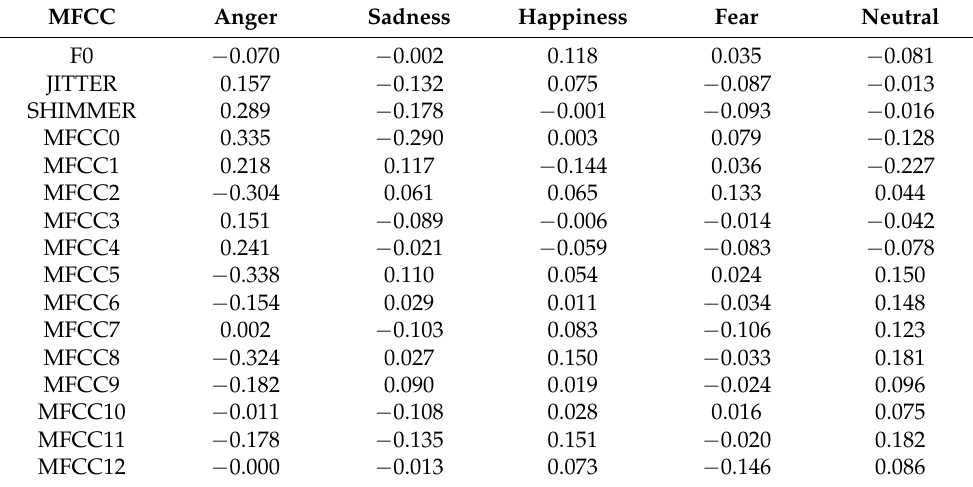
Table 8. Values of Pearson’s correlation